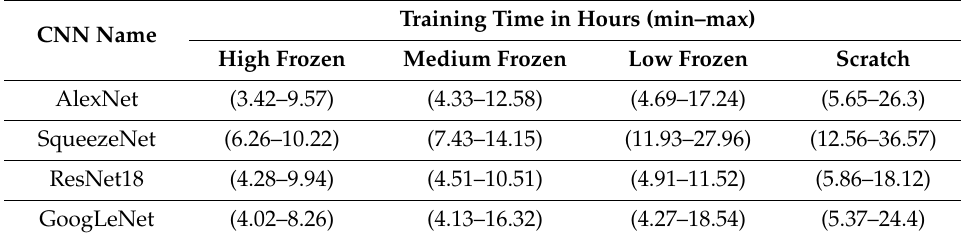
Table 9. CNNs training